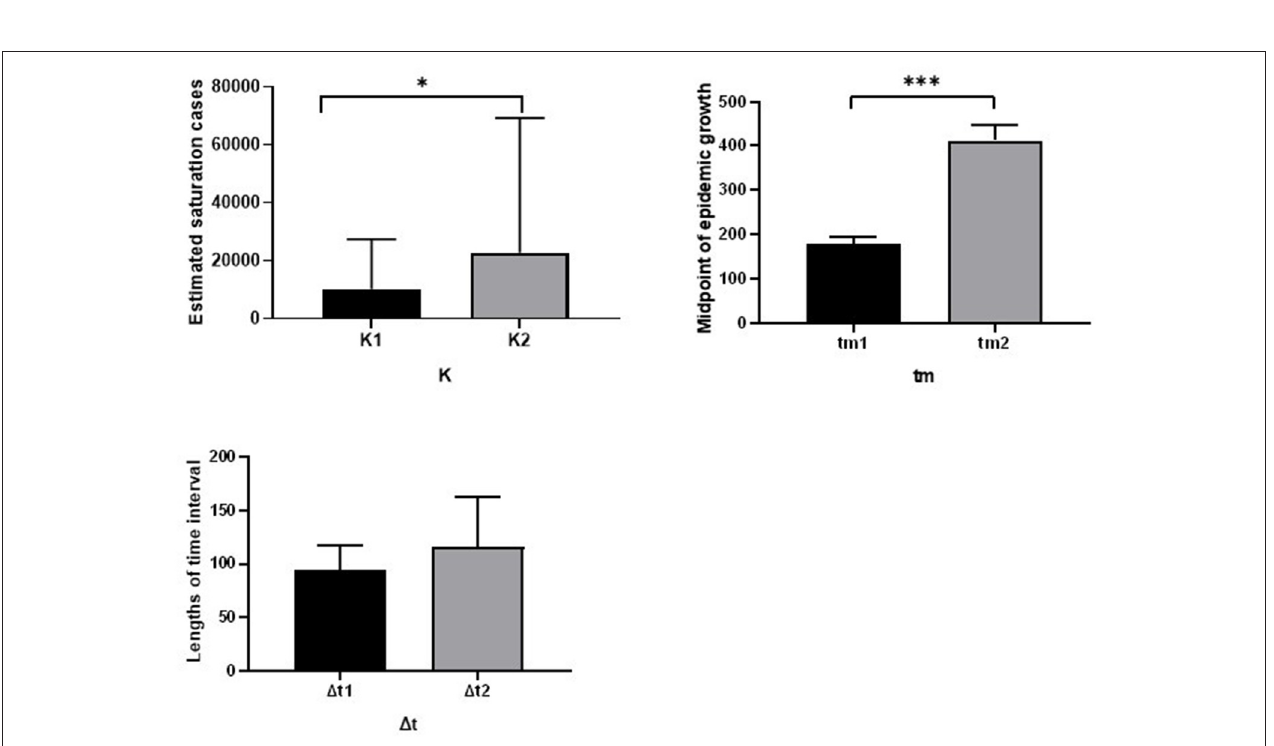
FIGURE 3 | Comparison of the fitted parameters for the bi-logistic approximation of 10 regions and 2 administrative cities of Ethiopia. * indicate P < 0.05, *** indicate P < 0.001.